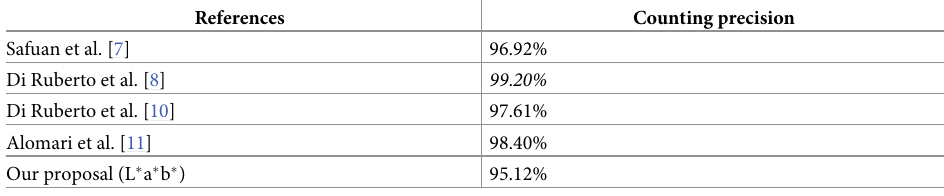
Table 6. Counting precision comparison of different